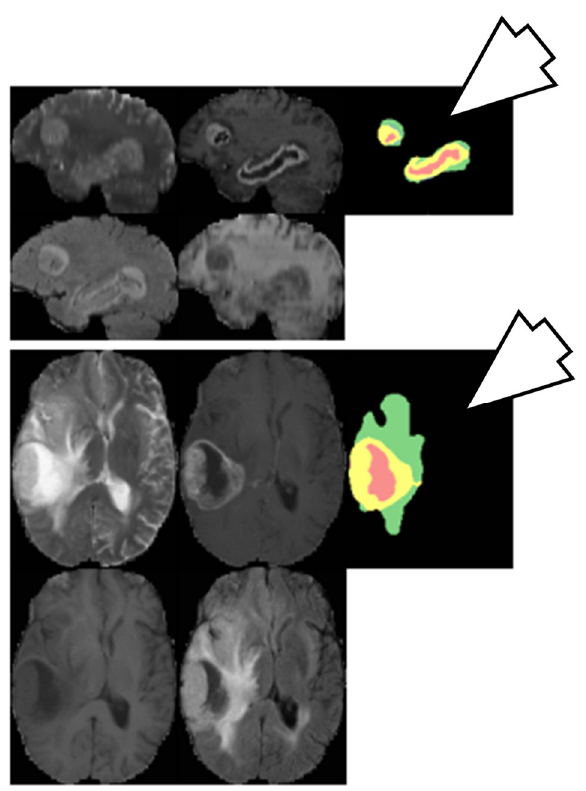
Figure 14. Segmentation results from two different patients. Green: edema, yellow: enhanced tumor, pink: necrosis, blue: non‐enhanced tumor (reproduced from [103] with permission).